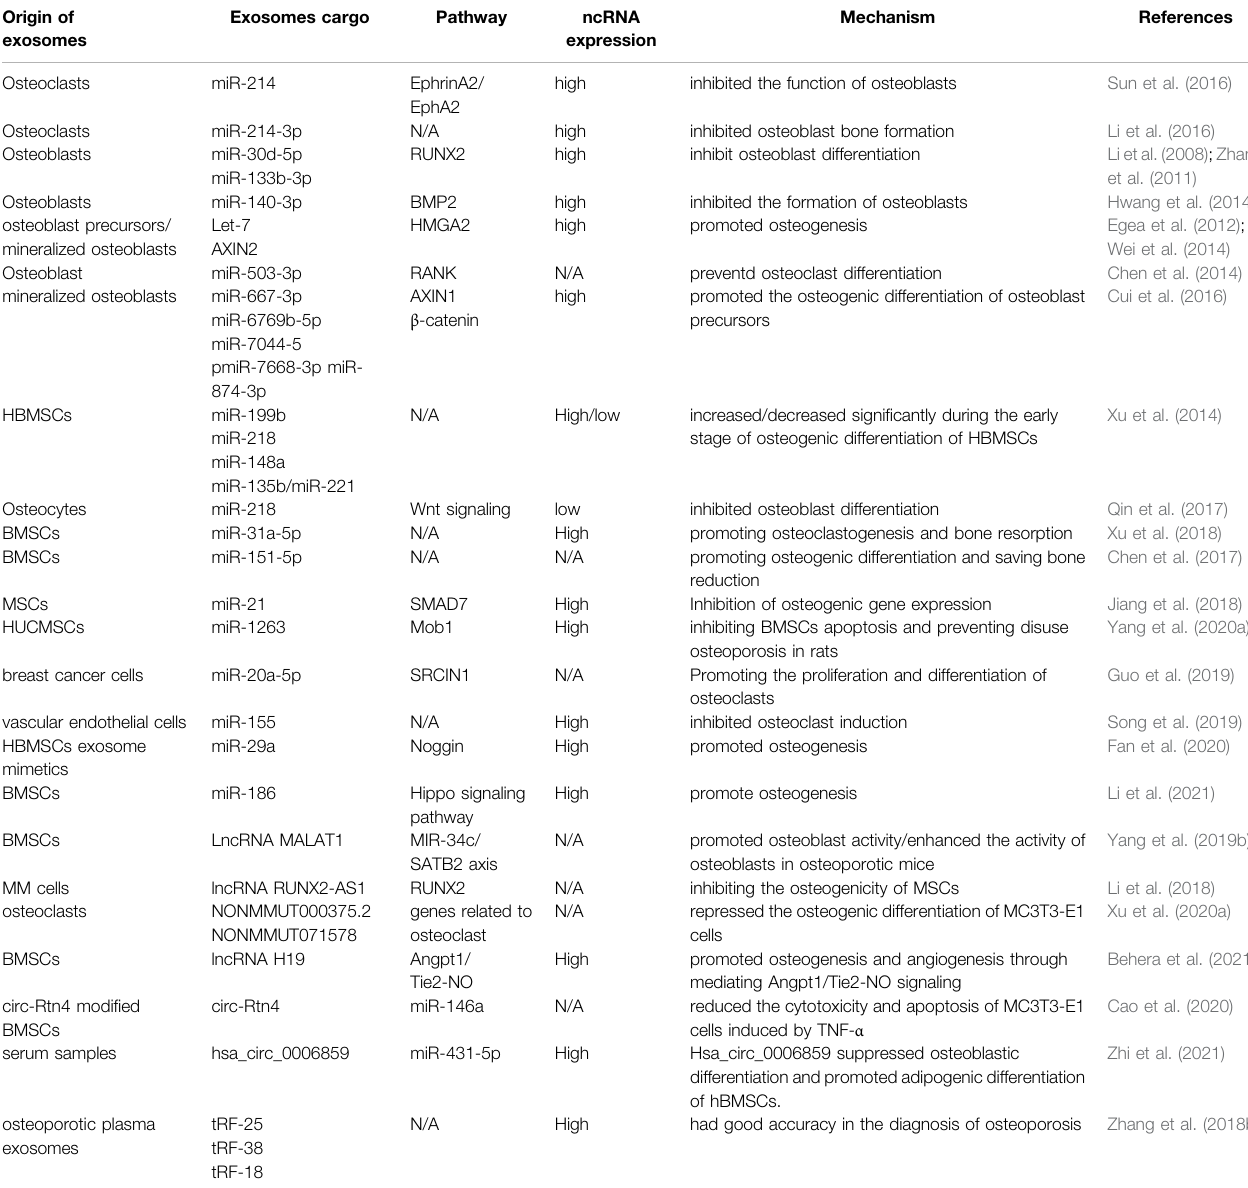
TABLE 1 | The role of exosomal non-coding RNAs in osteoporosis. Origin of